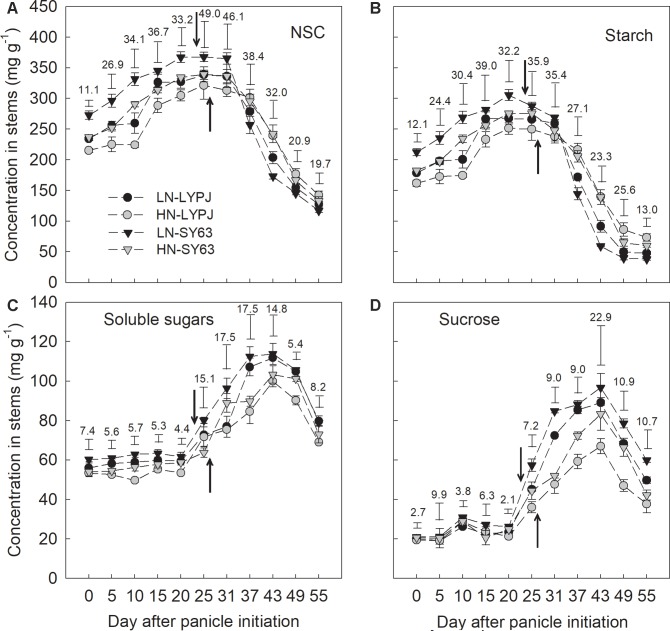
Concentrations of NSC (A), starch (B), soluble sugars (C), and sucrose (D) in the stems of LYPJ and SY63 cultivars under LN and HN treatments. Vertical bar with number represents LSD0.05 for difference significance of mean among 4 combinations at an identical time point. The downward and upward arrows indicate heading date (HD) under LN and HN. Data are shown as mean ± standard error (n = 3).